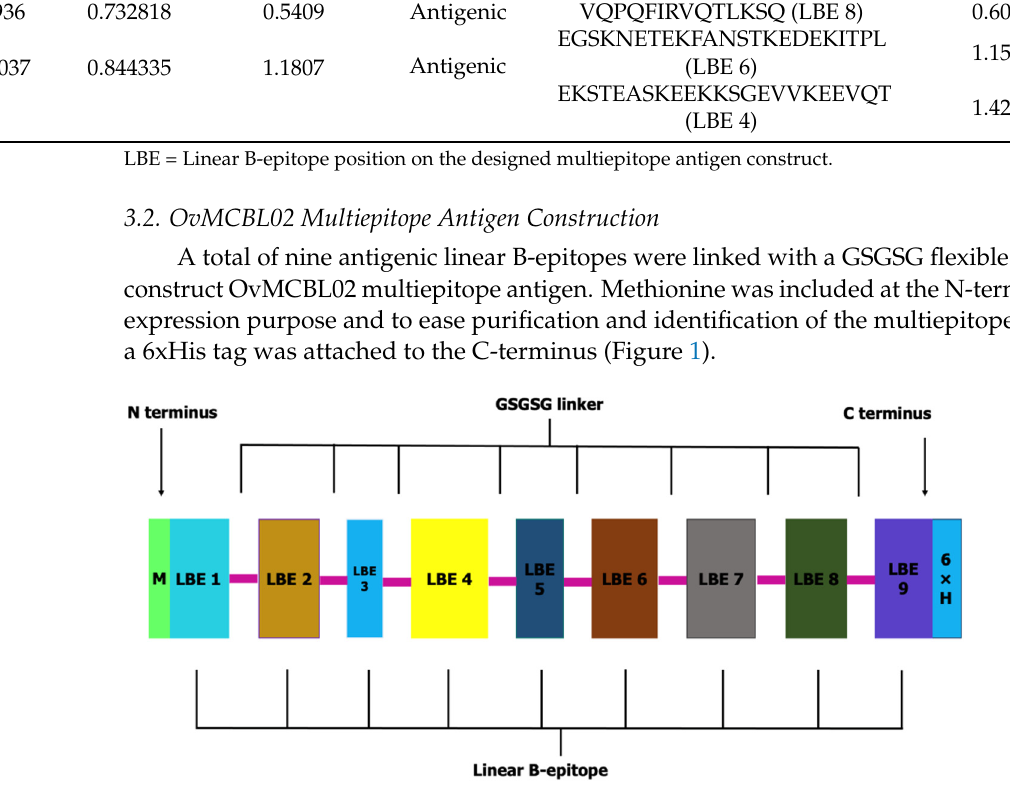
Figure 1. Schematic representation of OvMCBL02 multiepitope antigen with methionine coupled at the N-terminus and 6X His tag to its C-terminus. The various linear B-epitopes (LBE) are represented with different colors.